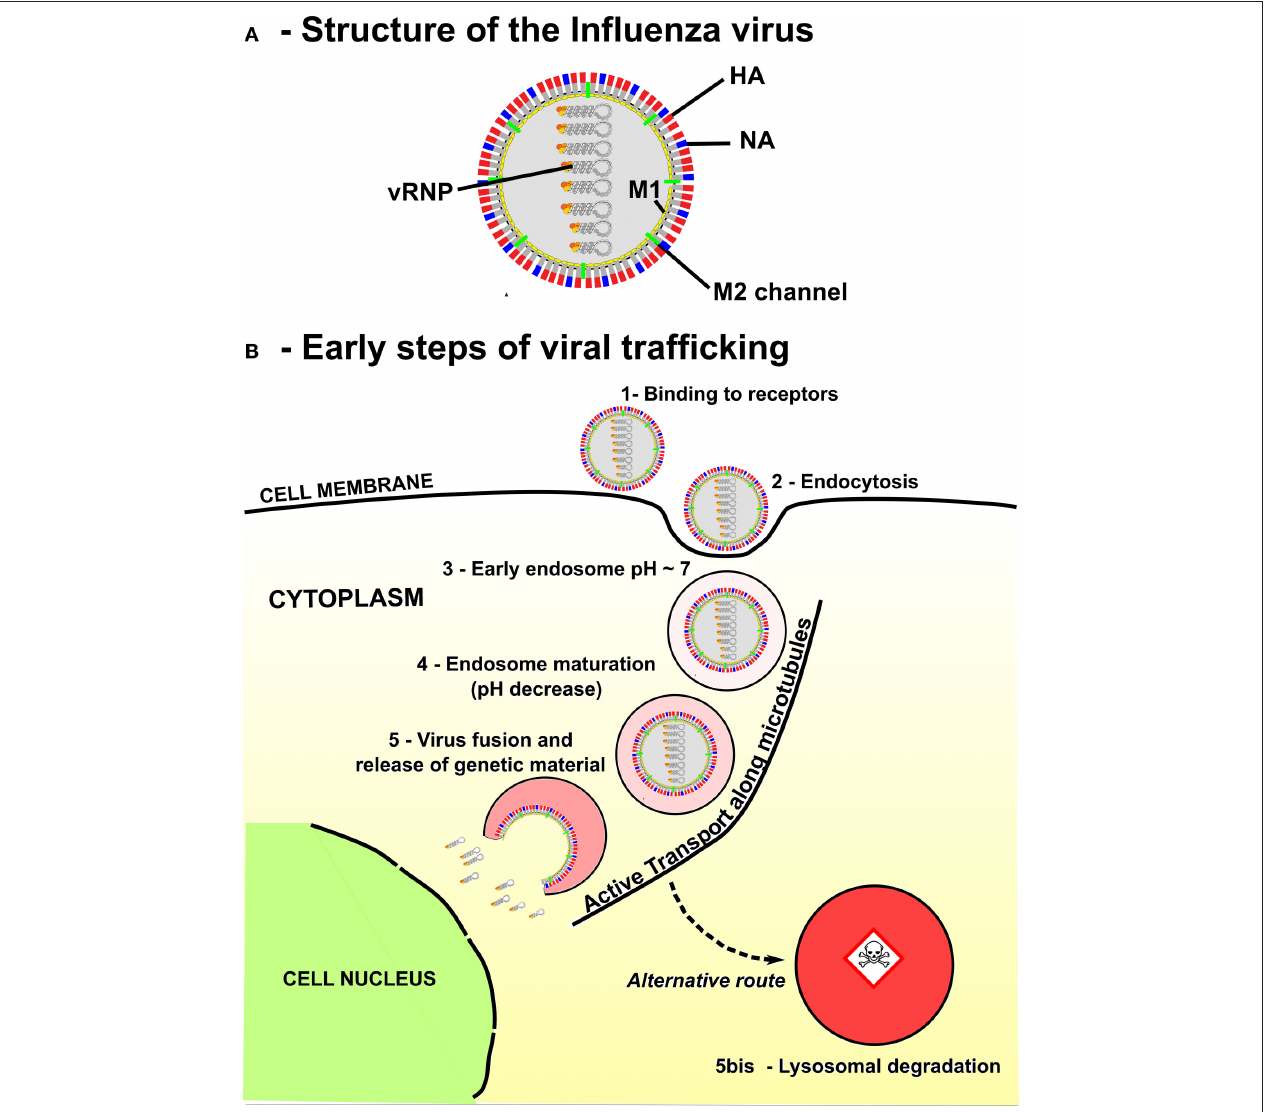
FIGURE 1 | Structure and endosomal trafficking of the Influenza virus. (A) Influenza is an enveloped virus. Main spike proteins anchored in the envelope are the neuraminidase (NA) and the Hemagglutinin (HA). Protons can access the core of the virus through M2 channels. Main matrix protein is M1 protein. Viral genome of the virus is composed by eight viral ribonucleoproteins (vRNPs). (B) Influenza virus enters the cell via receptor-mediated endocytosis and progress rapidly toward an early endosome. Then, maturation is associated with an acidification of the endosome lumen and a retrograde transport of the endosome along the microtubules toward the nucleus, the destination of vRNPS for virus replication. The final destination of many endosomes is the degradative lysosomes. Thus, the timing of Influenza virus escape has to be tightly regulated to avoid degradation in lysosomes while delivering the genetic material close to the